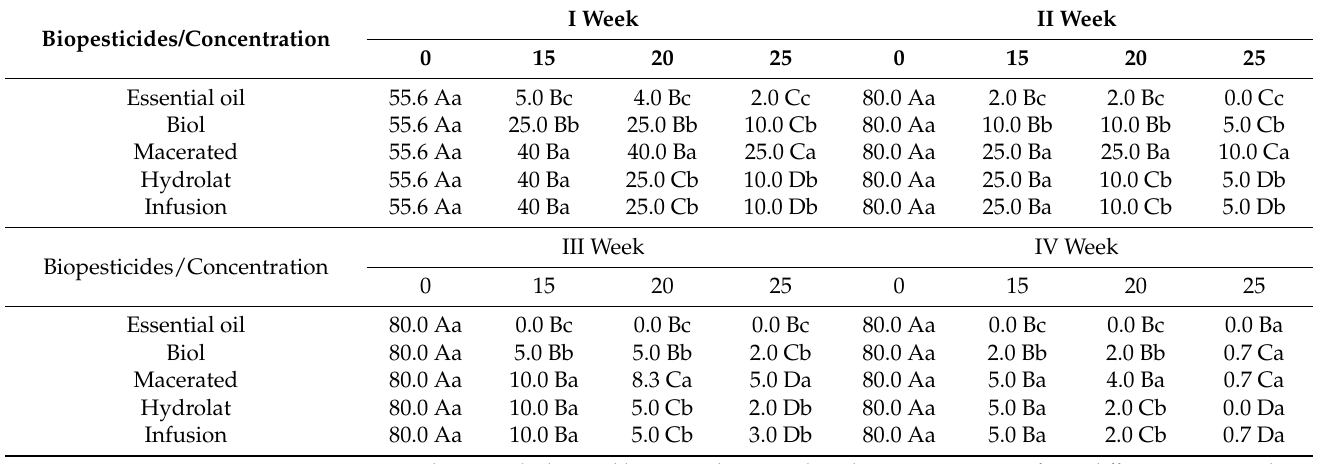
Table 4. Comparison of means in relation to the severity of five biopesticides for the control of coffee rust, applied at four concentrations and evaluated on four different dates after field application.